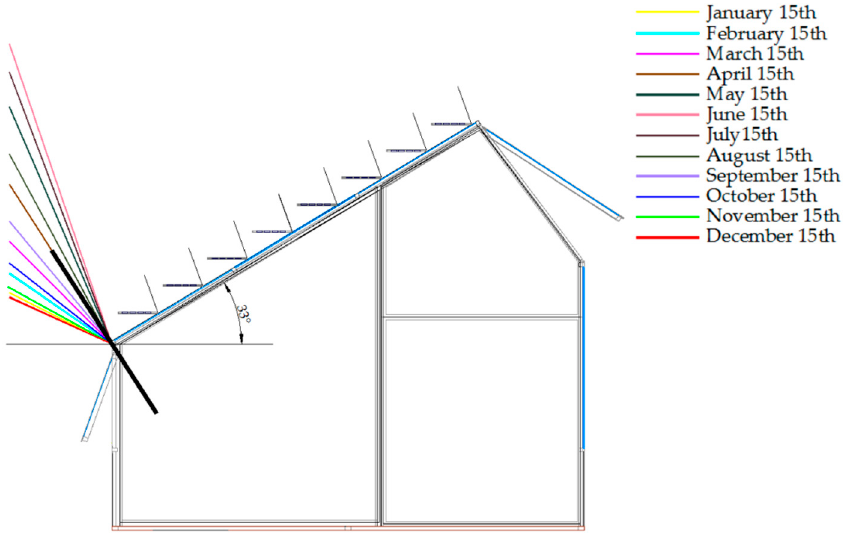
Figure 2. Photovoltaic panels in the fixed horizontal position and the different inclination angles of the sun’s rays during the year. The values refer to the 15th of each month. The latitude is 42.2° North. With the fixed and horizontal PV panels, in the autumn and winter months, the angle of incidence of solar rays is high with consequent losses of electric energy due to reflection. The solution that